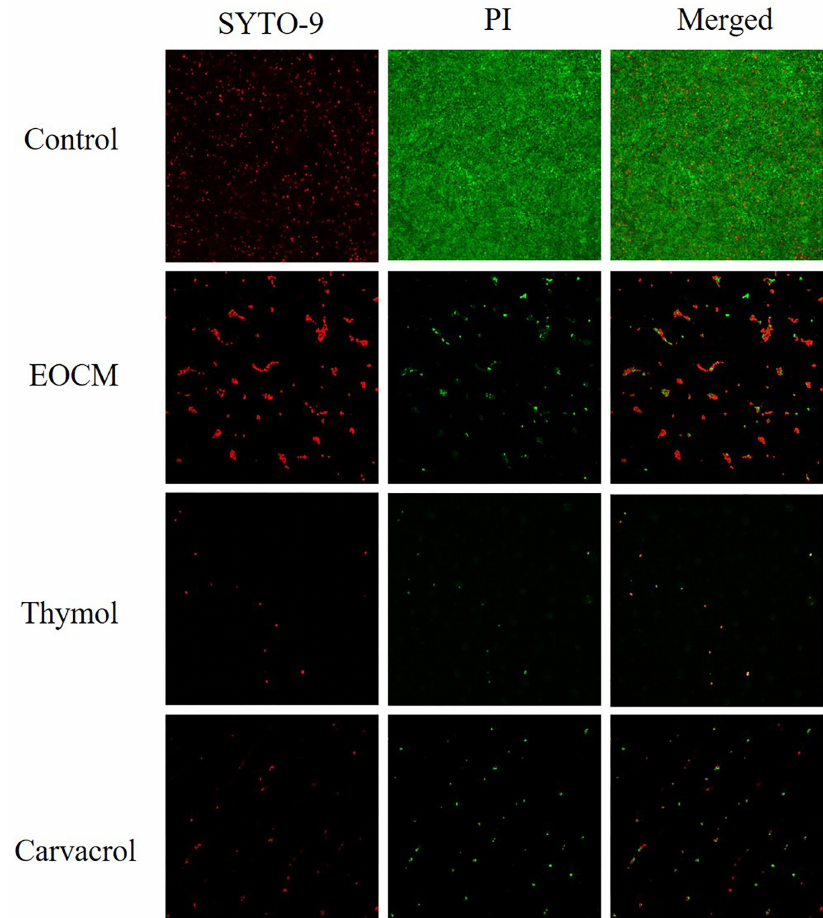
Figure 8. Effect of EOCM, thymol and carvacrol the growth of S. aureus biofilm under CLSM.